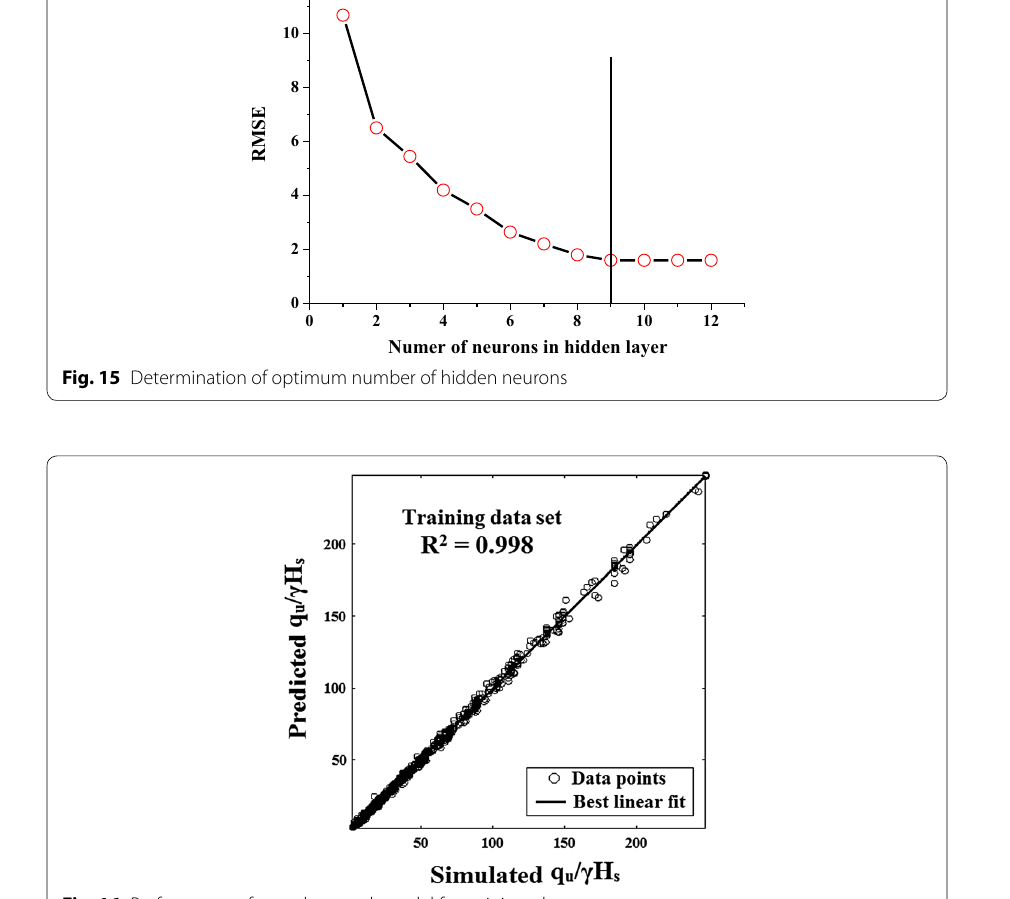
Fig. 16 Performance of neural network model for training